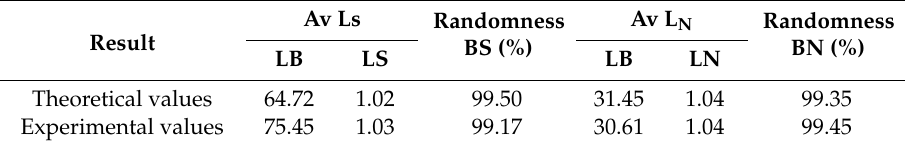
Table 6. Theoretical and experimental values of randomness.